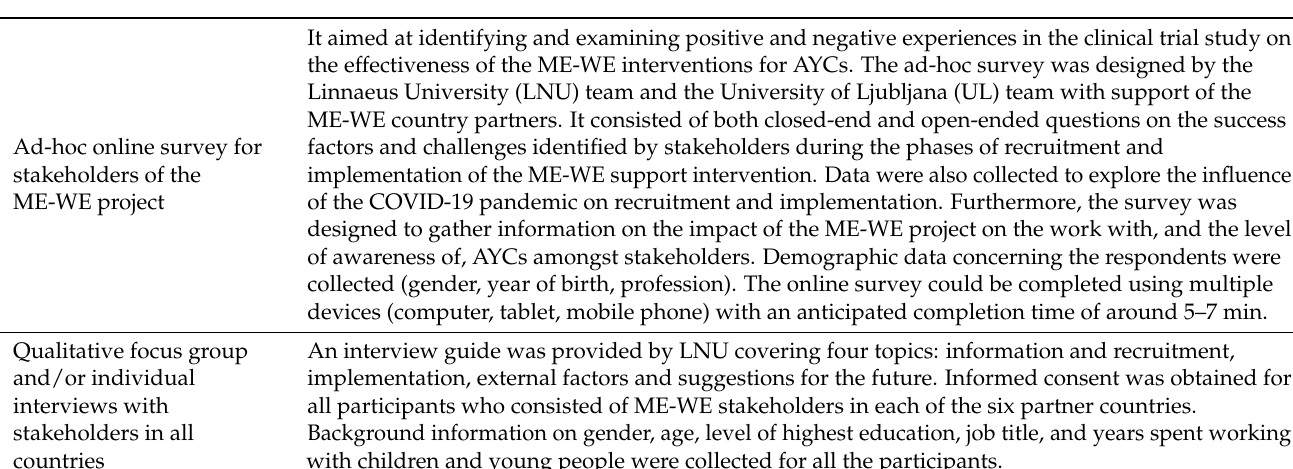
Table 2. Additional process evaluation data collection